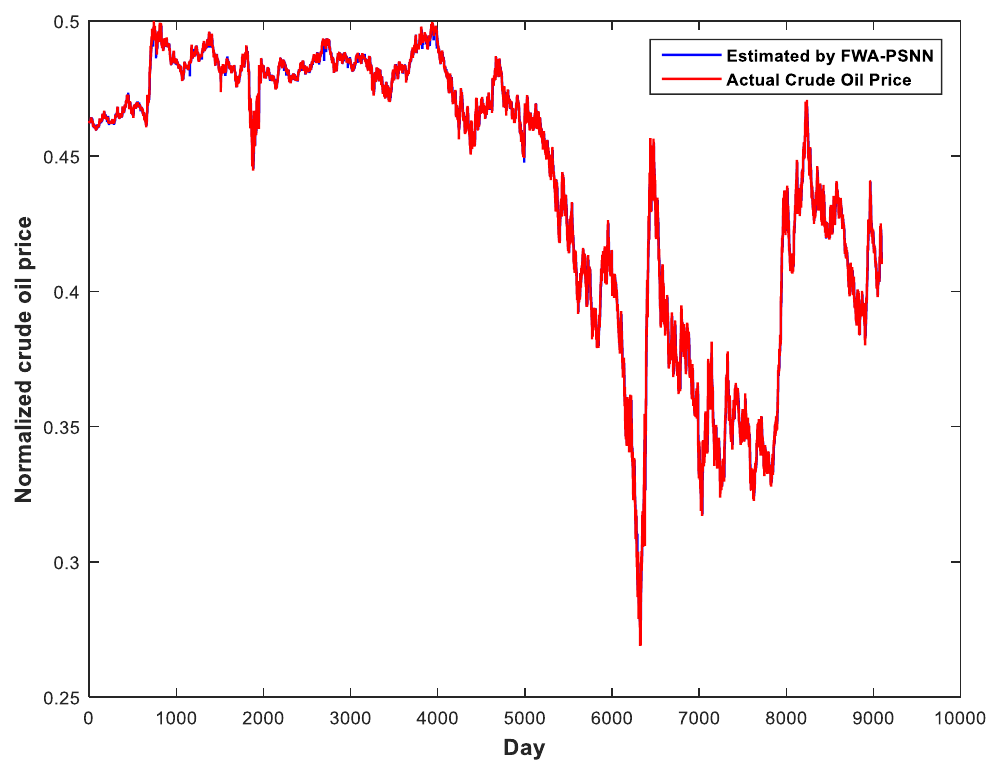
Figure 6. Actual crude oil prices v/s estimated by FWA-PSNN from daily crude oil price time